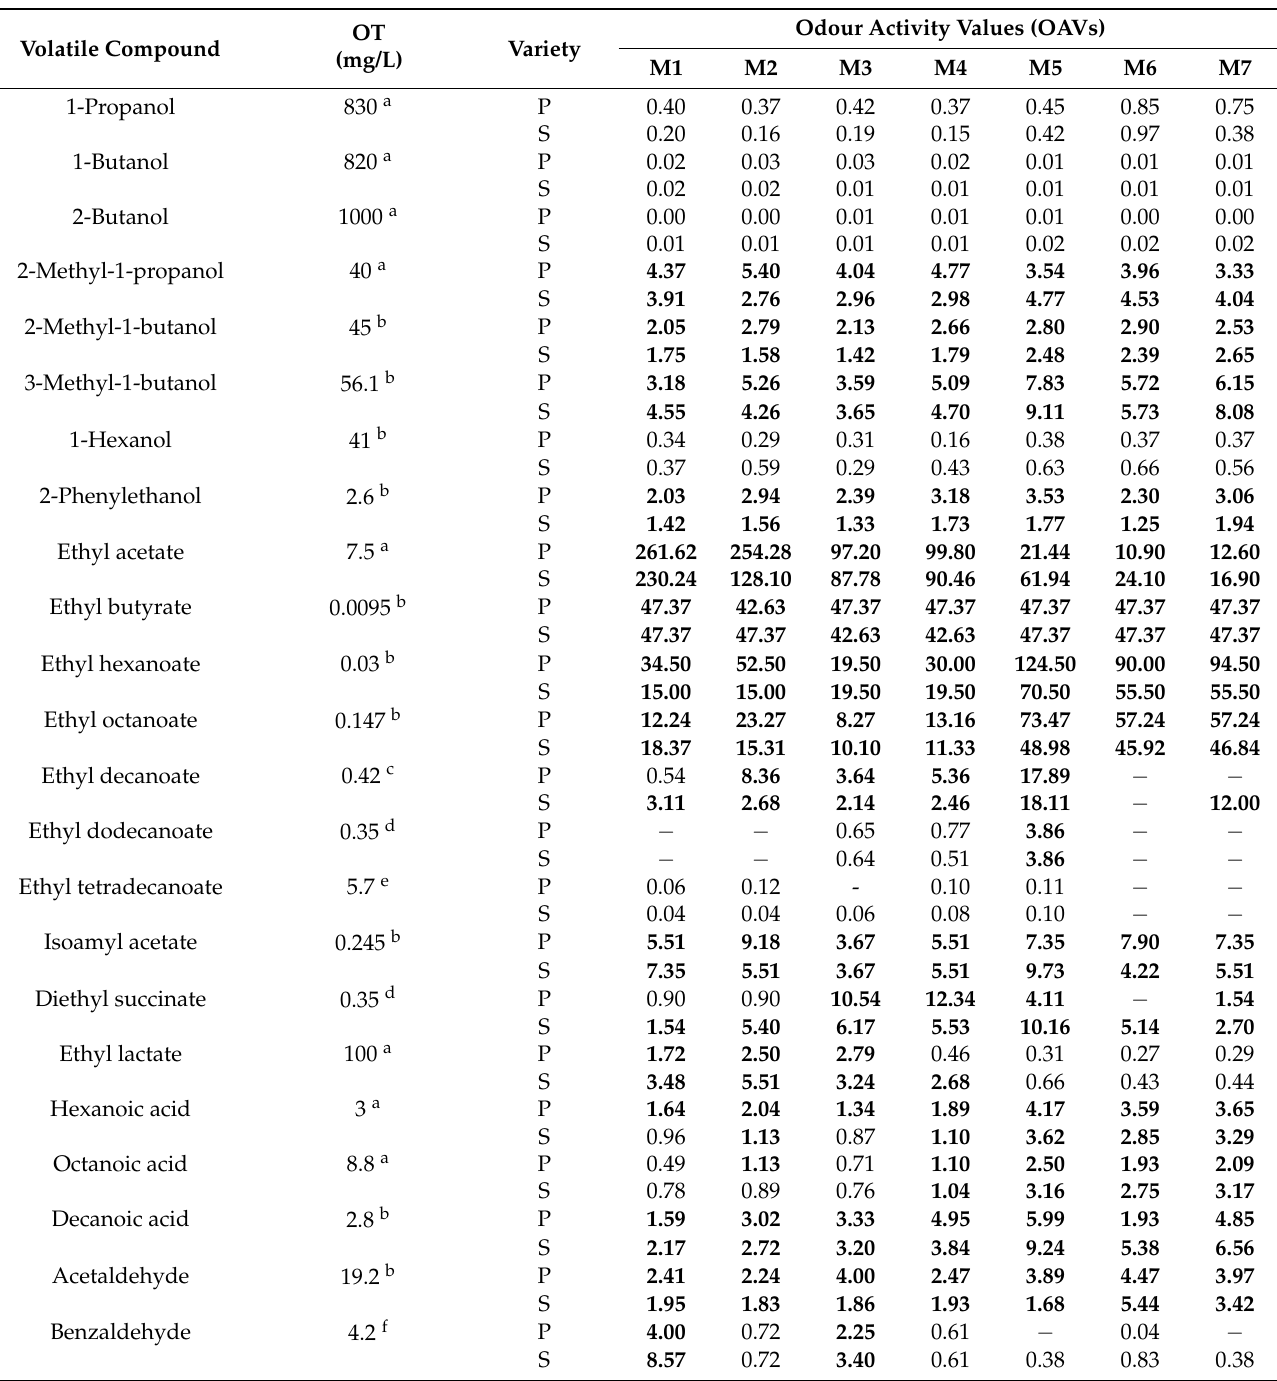
Table 2. Odour activity values (OAVs) of volatile compounds in plum spirits obtained by traditional (M1) and modified (M2–M7) production